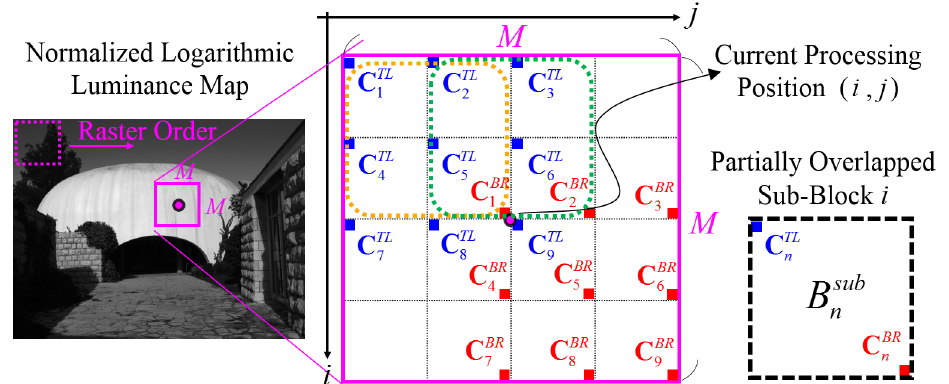
Figure 5. Local region analysis, where the orange and the green squares, respectively, indicate the first and the second partially overlapped subblocks of a local region (the pink square with size of M × M ). At each processing position, local features are extracted by the statistical analysis of nine subblocks defined in Equations (12) and (13), and its simplification is achieved by utilizing the summed-area table defined in Equations (16) and (17).